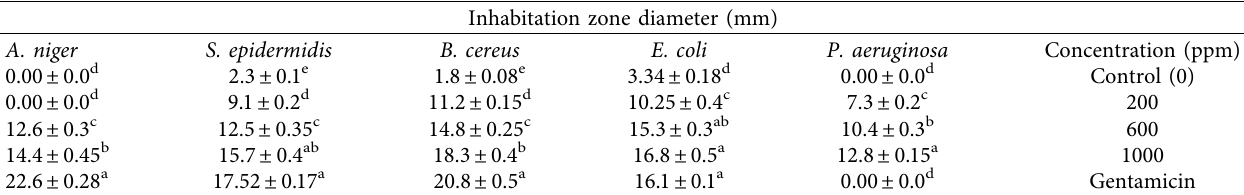
Table 5: Inhibitory activity of the methanolic extract of C. dactylon rhizome on the growth of microorganisms. Inhabitation zone diameter